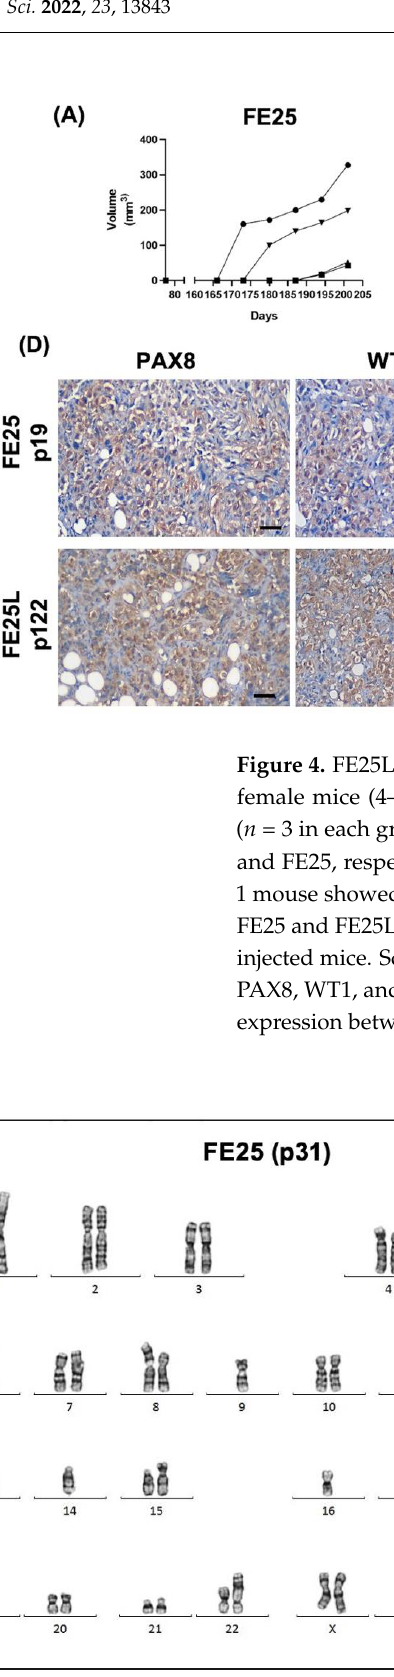
Figure 5. G-band karyotyping for FE25 (p31) and FE25 L (p139) cells. Representative karyotyping chromosome images of ( A ) FE25 and ( B ) FE25L cells. Numbers under each chromosome were chromosome